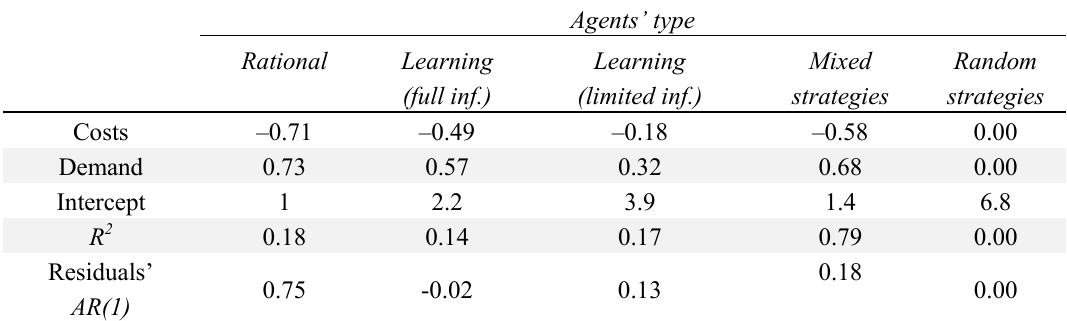
Table 2. GMM regressions for output as the dependent